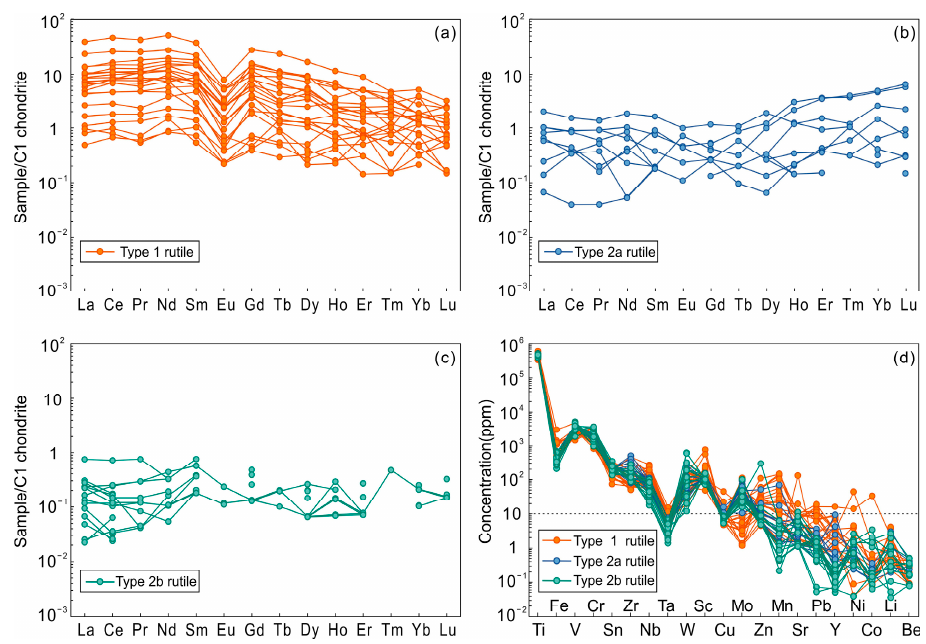
Figure 6. REE patterns ( a – c ) and trace element contents ( d ) of three types of rutile from Tuwu.